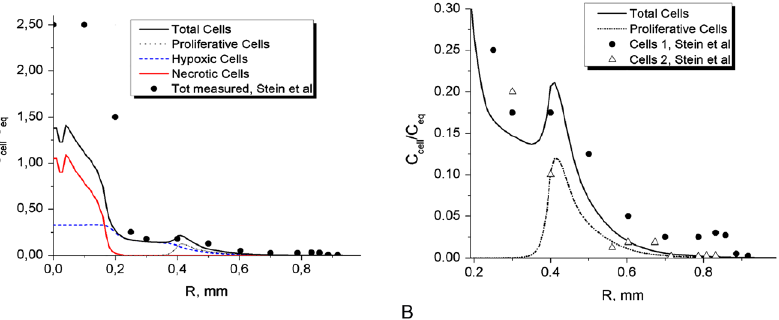
Figure5: Comparisontheresultsofcalculationwithexperimentaldataforday3ofMTSgrowthobtainedin[68]fortheU87WTcell line (solid spheres). The fi gures present calculated distributions of total cell density obtained for D O2 = 40.0 mm 2 /day; Proliferative, hypoxic and necrotic cells in different scales for clear comparison (A) and